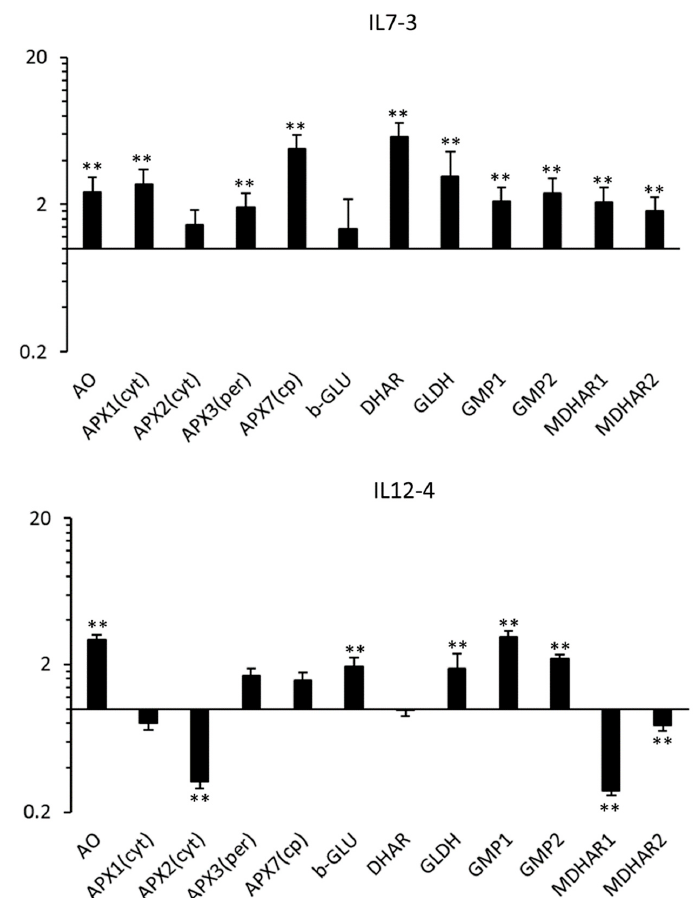
Figure 6. Relative gene expression by real-time PCR of genes involved in AsA biosynthesis. For each genotype (M82, IL7-3 and IL12-4), quantities (RQ) are relative to the calibrator condition (fruit explant) and are graphed on a logarithmic scale. For each gene, asterisks indicate that the 2 −∆ Ct values were significantly different between the test (calli at 60 days) and calibrator condition (** p < 0.01; t- test).